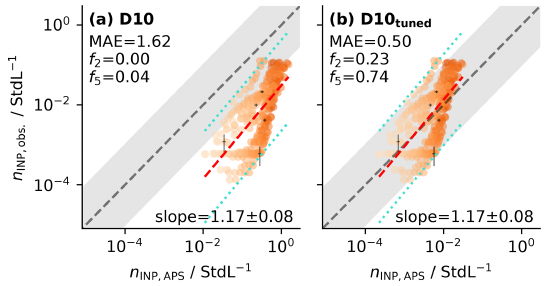
Figure 6. Same as for Fig. 5a but comparing in situ INP concentra- tions ( n INP , obs . ) measured at WFJ (mountaintop site, Fig. 1) to pre- dicted INP concentrations ( n INP , APS ) based on D10 now applied to in situ aerosol concentrations (from APS) during continental back- ground (see Fig. 3). (a) D10 applied to in situ aerosol concentrations (from APS) in its standard form. (b) D10 shifted towards the 1 : 1 line, maximizing the fraction of data points within 1 order of mag- nitude around the 1 : 1 line (see Eq.